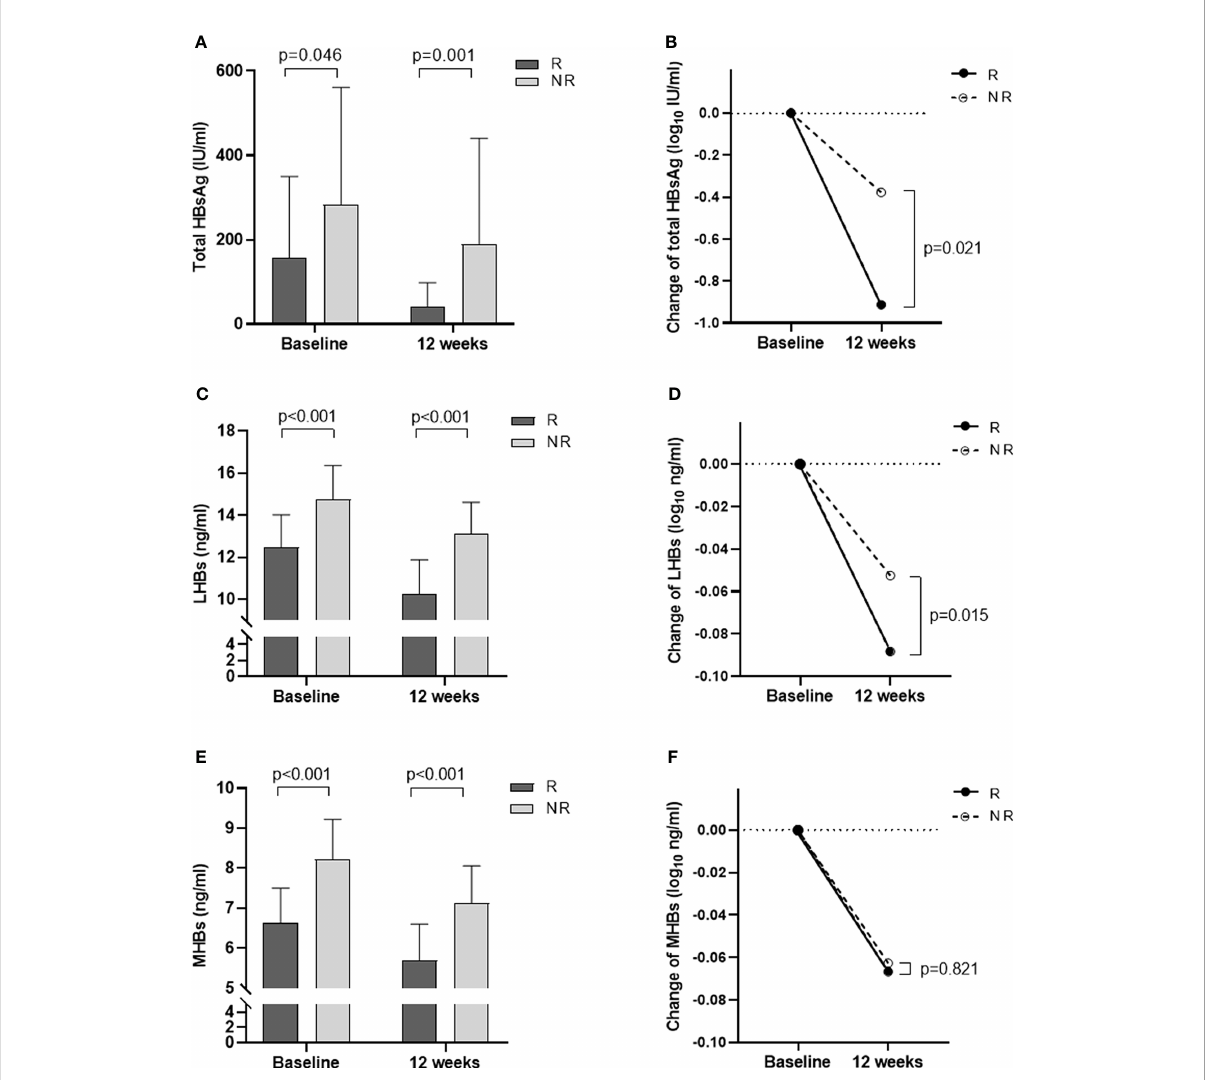
FIGURE 1 Changes in total HBsAg, LHBs, and MHBs at baseline and 12 weeks of treatment in the R and NR groups. (A) Total HBsAg levels at baseline and 12 weeks. (B) The degree of decline in total HBsAg from baseline to 12 weeks (log). (C) LHBs levels at baseline and 12 weeks. (D) The degree of decline in LHBs from baseline to 12 weeks (log). (E) MHBs levels at baseline and 12 weeks. (F) The degree of decline in MHBs from baseline to 12 weeks